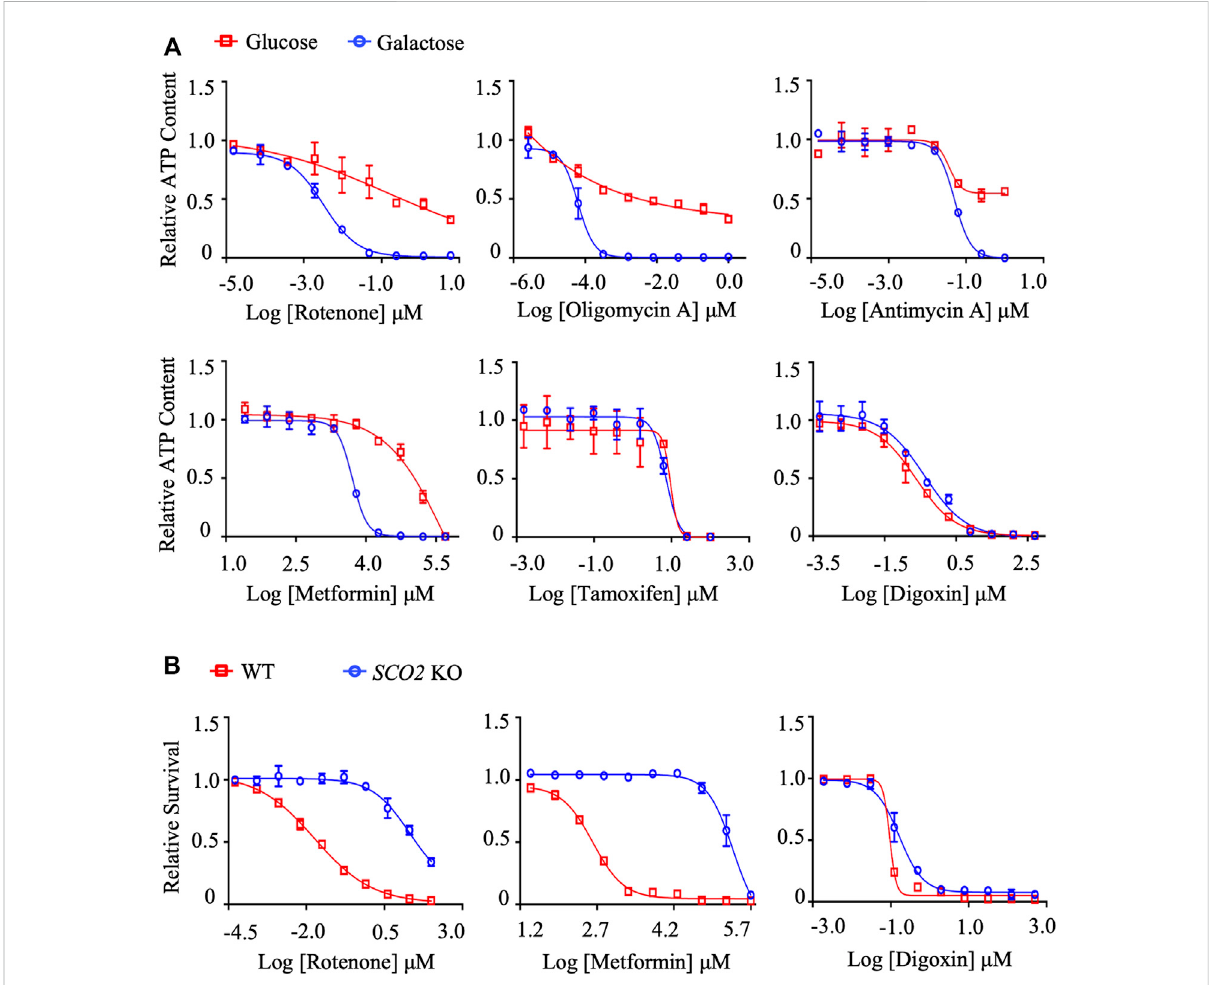
FIGURE 1 The establishment and validation of the dual in vitro mitochondrial toxicity assay system. (A) Concentration responses for high-glucose-grown (25 mM) and galactose-grown (10 mM) (blue) HepG2 cells treated with rotenone, oligomycin A, antimycin A, metformin, tamoxifen, and digoxin. After 48 h of treatment, the ATP content was assessed. (B) HCT-116 (WT; SCO2 KO) cells were treated with indicated concentrations of rotenone, metformin, and digoxin for 72 h. Cell viability was assessed by the SRB assay. Average values are from three independent experiments performed in duplicate ( n = 3). Data are shown as mean ±